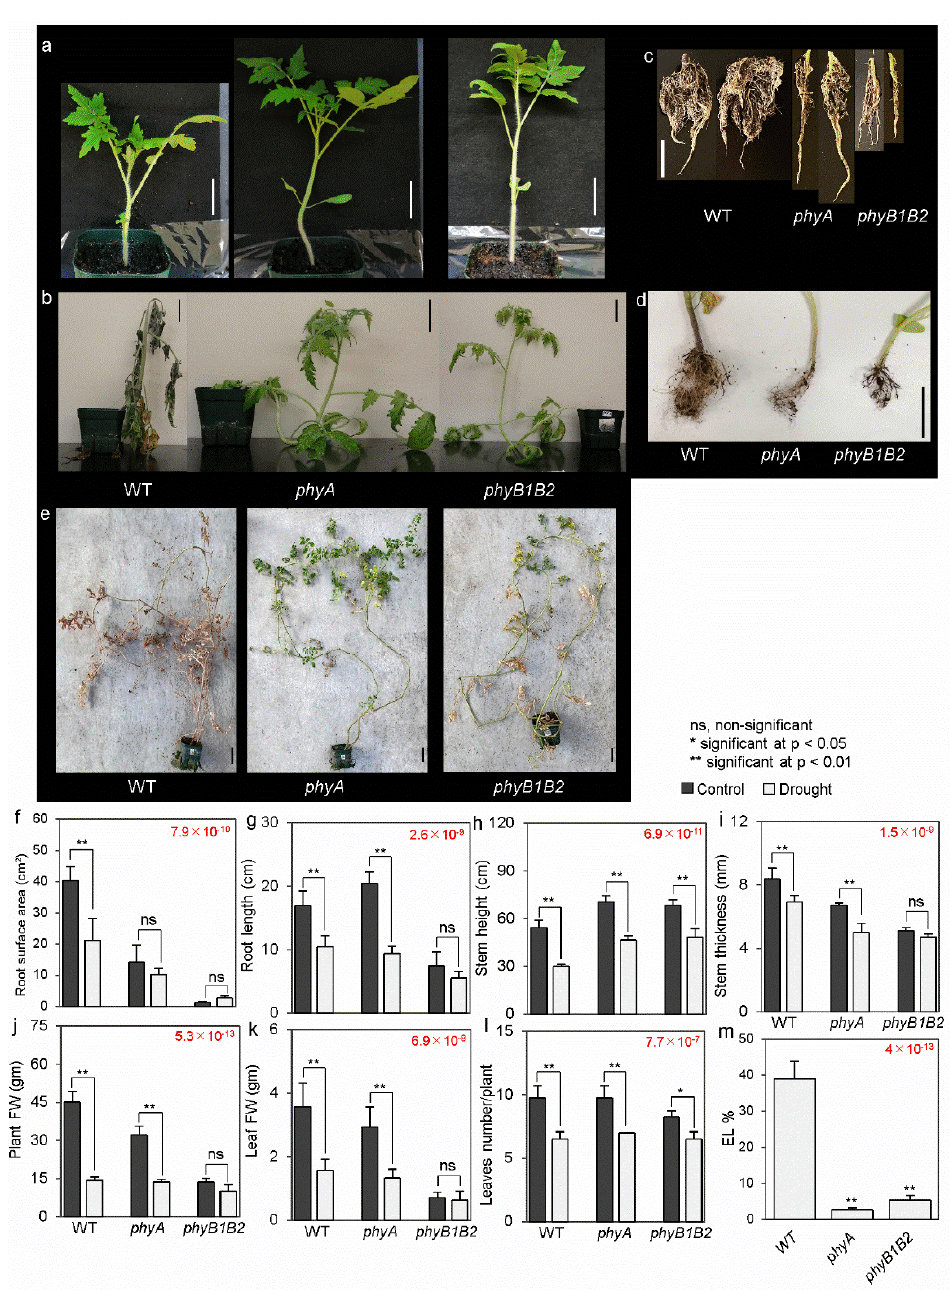
Figure 1. Phenotypic characteristics of WT, phyA , and phyB1B2 plants under drought stress. ( a ) The morphological phenotype under non-stress conditions. ( b ) The morphological phenotype of a month-old plant after water withholding for 8 days (d). Root phenotype of one-month-old plants after 8 d under non-stress ( c ) or drought conditions ( d ). ( e ) The morphological phenotype after 12 d of water withholding in the flowering stage under greenhouse conditions. The scale bars represent 5 cm. Surface area and length of roots ( f , g ), stem height and thickness ( h , i ), fresh weight (FW) of plant and leaf ( j , k ), and the number of leaves/plant ( l ) were measured in month-old plants after exposure to water withholding for 8 d compared to control conditions. ( m ) Electrolyte leakage (EL) % of a month-old plant’s leaves after 8 d of water withholding. The values represent the average ( n ≥ 4) ± SD (standard deviation) from a representative of three separate biological experiments. * Sig- nificant difference in statistical analysis at p < 0.05; ** significant difference at p < 0.01; ns, non-sig- nificant variations between studied genotypes under stress conditions for the EL% parameter and between non-stress and stress conditions in each genotype individually for the other parameters in accordance with a post hoc Tukey HSD test with ANOVA. The ANOVA p-values are shown in red color. Additionally, the p -values of the post hoc test are presented in Supplementary Materials (Ta- bles S1 and S2).